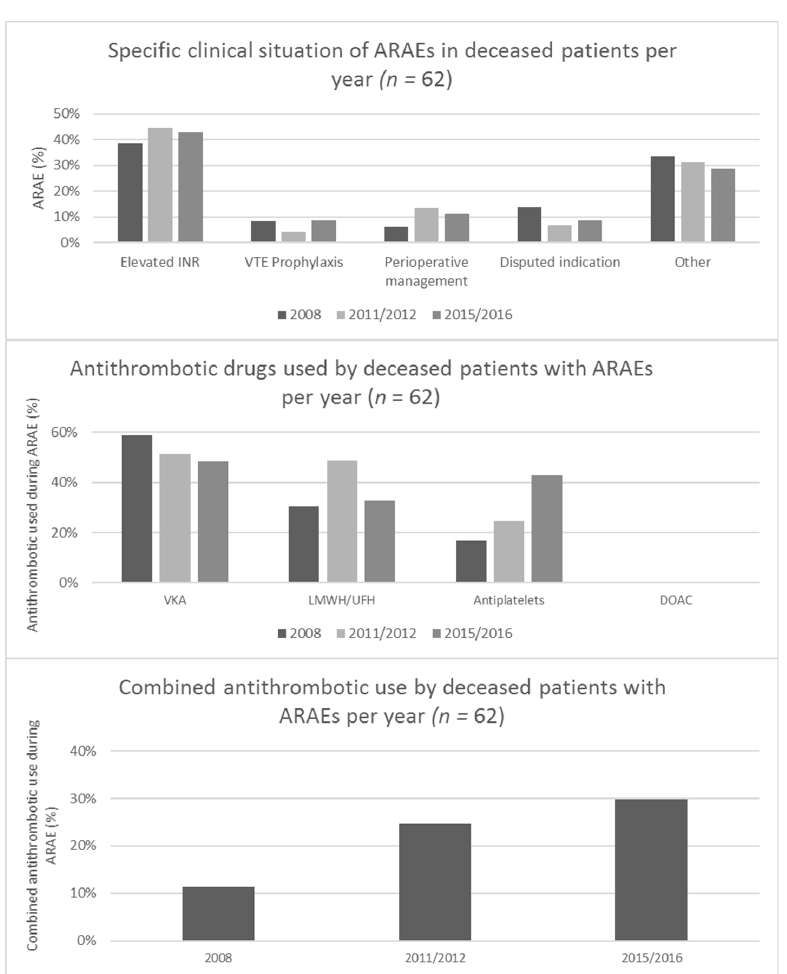
Figure 3. Longitudinal overview of clinical context and antithrombotic drugs involved in ARAEs in deceased patients.